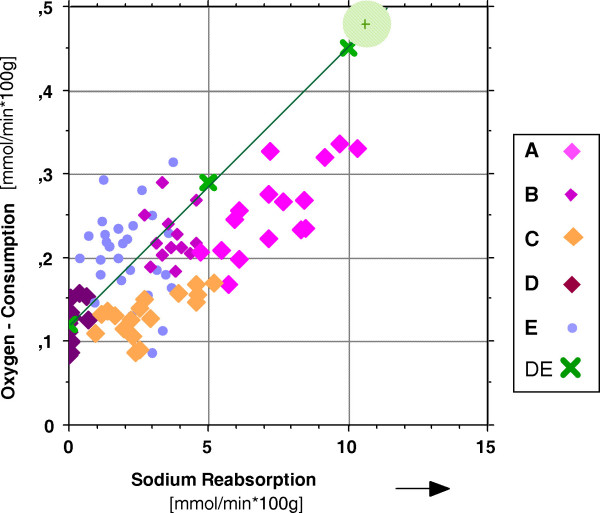
Oxygen consumption O2 cons versus fractional sodium reabsorption RFNa for isolated kidney experimental groups A – E, for the control group CON of living pigs (green shadowed area) and for in vivo measurements DE (modified from: [50]).